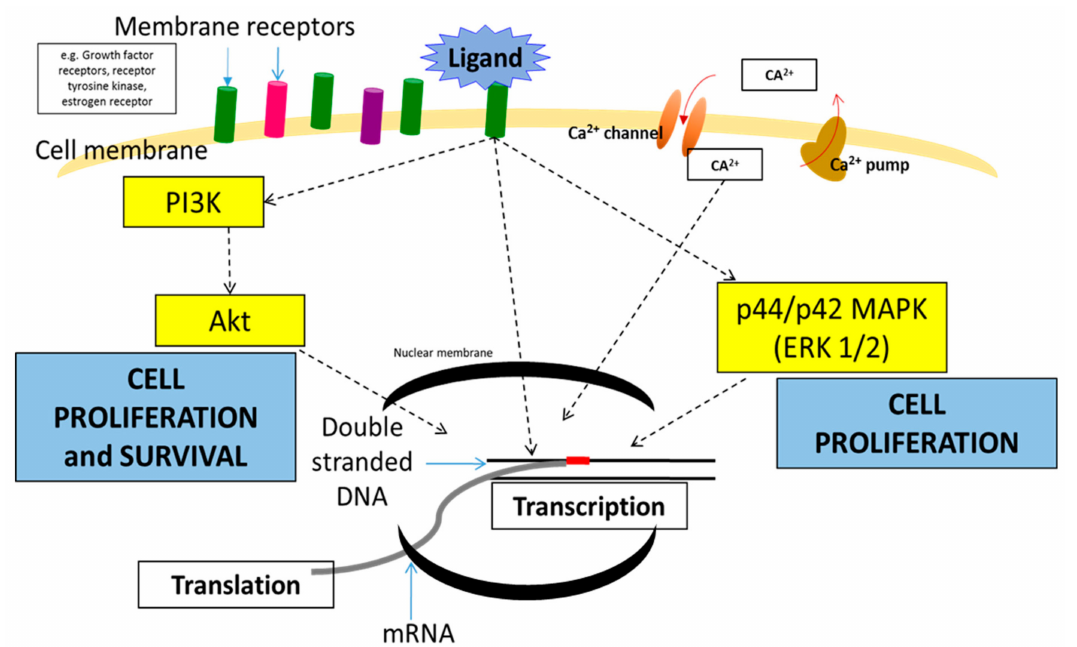
Figure 1. Diagram of several signaling pathways in breast cancer that lead to proliferation and survival of breast cancer